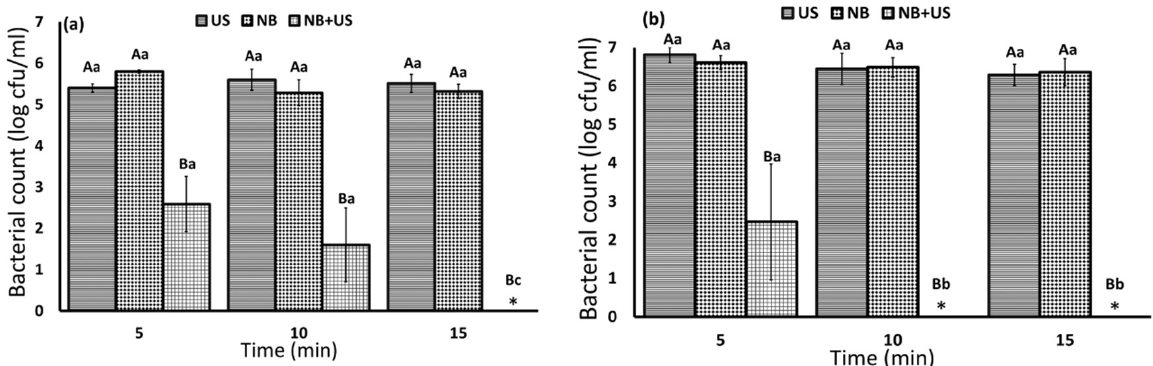
Figure 1. ( a ) L. innocua and ( b ) E. coli counts in nanobubbles (NB), ultrasound (US) and nanobubbles + ultrasound (NB+US) treated samples at different exposure times. Statistical difference was determined based on p < 0.05 (*). Limit of detection was below 0.5 log cfu/mL. The initial number of bacteria was 6.2 and 7.18 cfu/mL for L. innocua and E. coli , respectively. Capital letters indicate the significant differences among the treatments at given time, and lower case letters indicate the significant differences of specific treatment at different times.